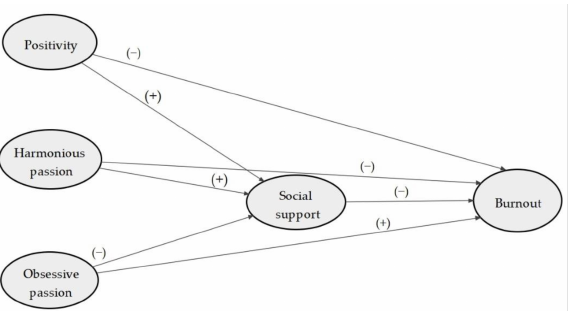
Figure 1. Representation of Structural Model of Positivity, Passion, Social support and